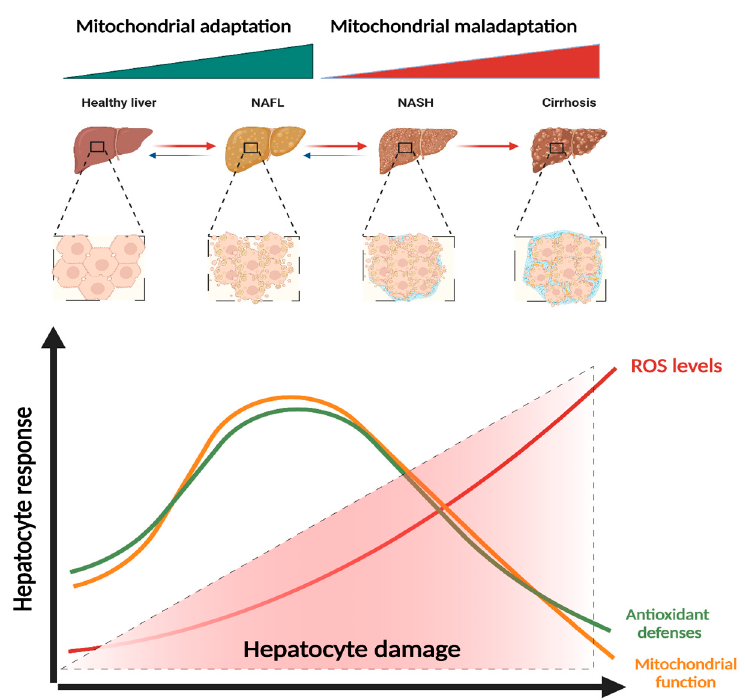
Figure 2. Mitochondrial adaptation and maladaptation in NAFLD progression. Different stages of Non-alcoholic fatty liver disease (NAFLD), comprising non-alcoholic fatty liver (NAFL), non-alcoholic steatohepatitis (NASH), cirrhosis, and hepatocellular carcinoma (HCC). During NAFLD progression, mitochondria increase their function in order to counteract lipotoxic insults. However, uncontrolled stimulation of basal ROS production or failure of antioxidant defenses to neutralize ROS results in exacerbated ROS levels that lead to oxidative stress and culminate in hepatocyte injury. ROS, reactive oxygen species. Created with BioRender.com (accessed on 5 February